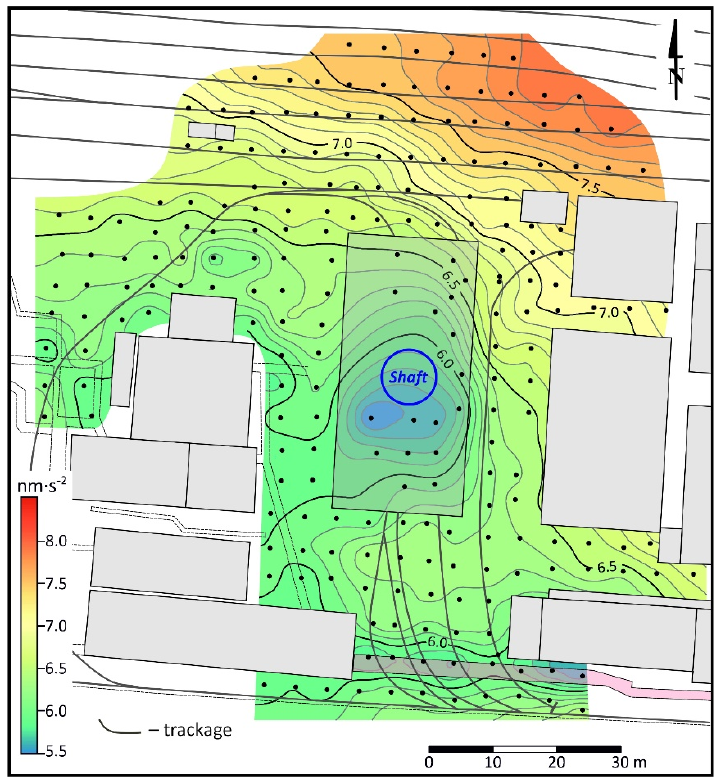
Figure 2. The distribution of Bouguer anomalies (black dots—the observation points).